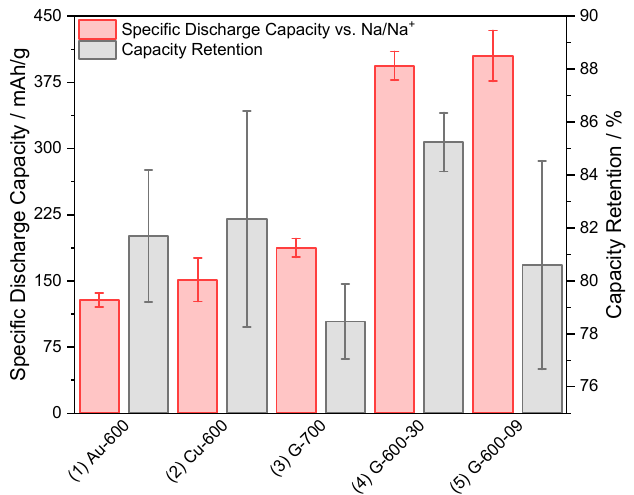
Figure 5. Summary of the average initial reversible capacities (red), and capacity retention (grey) between the 5th and 50th cycle, with errors, when cycled against Na/Na + .